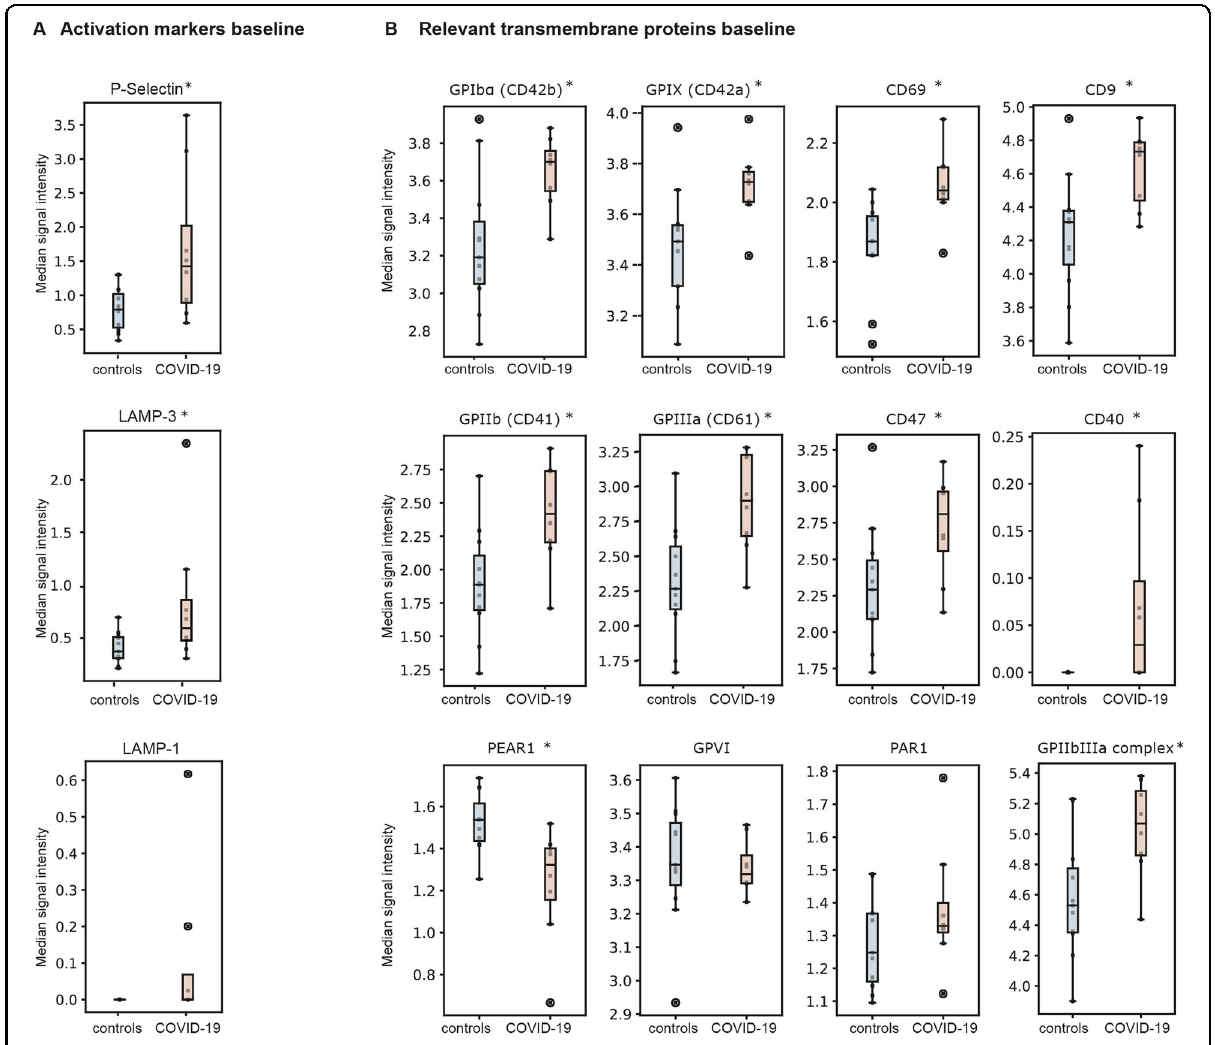
Fig. 2 Marker expression in non-stimulated platelets. Median signal intensity of activation markers ( A ) and relevant transmembrane proteins ( B ) in non-stimulated platelets. COVID-19 patients are plotted in red, whereas controls are plotted in blue. The horizontal line within the box plot represents the median, the top and bottom the interquartile range(Q1 – Q3), whisker bars indicate the largest observation that is less than or equal to the upper inner fence (UIF = Q3 + 1.5 × IQR) or the smallest observation that is greater than or equal to the lower inner fence (LIF = Q1 – 1.5 × IQR) and the circles indicate outliers, if present; * P < 0.01. N = 8 COVID-19 patients, 11 healthy